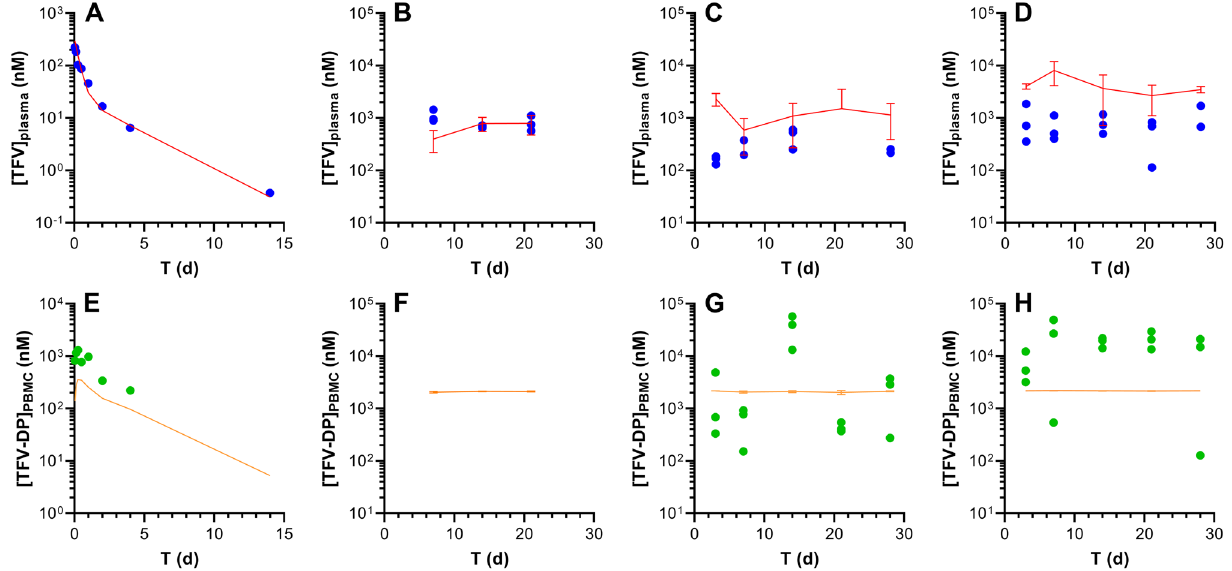
Figure 8. Simulation of plasma TFV and intracellular (PBMC) TFV-DP concentration–time profiles in mice following TAF dosing, using the IV/SQ PK model (Fig. 7) and implant release characteristics (Fig. 1). Circles represent individual experimental data; blue, plasma TFV; green, PBMC TFV-DP; lines represent model simulations (mean ± SD ); red, plasma TFV; orange, PBMC TFV-DP. ( A and E ) goodness-of-fit of IV data used an internal validation. ( B and F ) Simulation of plasma TFV and PBMC TFV-DP concentrations for a low-releasing (0.23 mg d -1 ) implant from a previous study 32 , where PBMC TFV-DP concentrations were not measured. ( C and G ) Simulation of plasma TFV and PBMC TFV-DP concentrations for the low-releasing (0.28 mg d -1 ) implant group. ( D and H ) Simulation of plasma TFV and PBMC TFV-DP concentrations for the high-releasing (0.58 mg d -1 ) implant